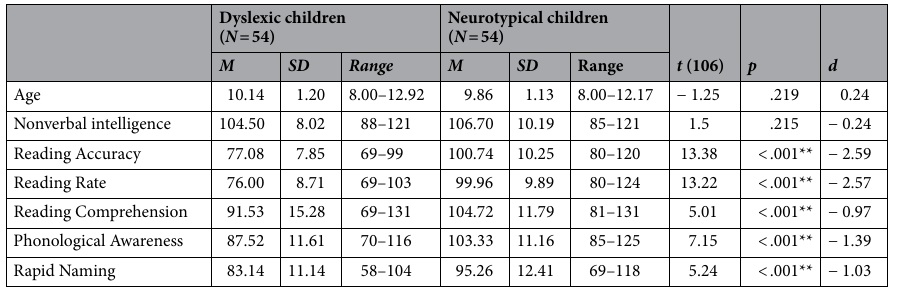
Table 4. Descriptives and comparisons of dyslexic and neurotypical children. All scores, except for age, are reported as standard scores; Cohen’s d ≥ 0.2, d ≥ 0.5, and d ≥ 0.8, represent small, medium, and large effect sizes,